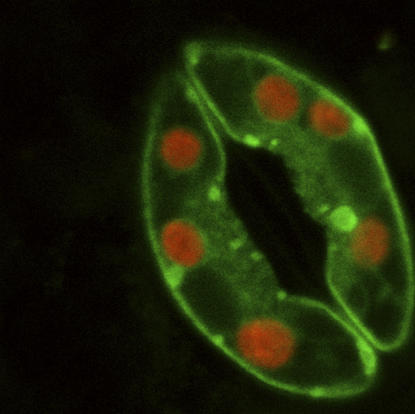
Confocal image of an Arabidopsis stomate showing two guard cells exhibiting green fluorescent protein and native chloroplast (red) fluorescence. (Image: Alex Costa)